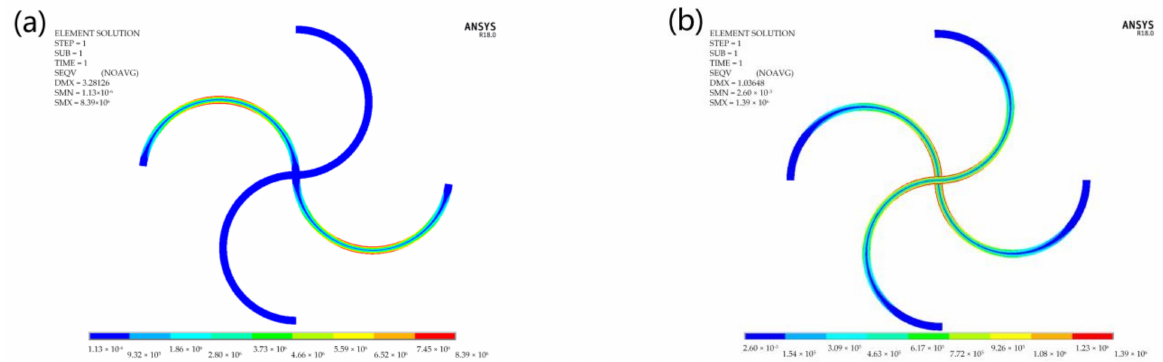
Figure 12. Stress distribution of the structure under in-plane: ( a ) axial load along the x-direction and ( b ) shear